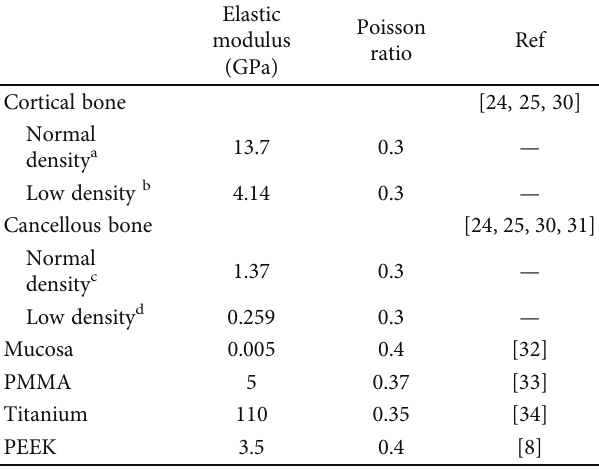
Table 2: Material properties used in the fi nite-element model.